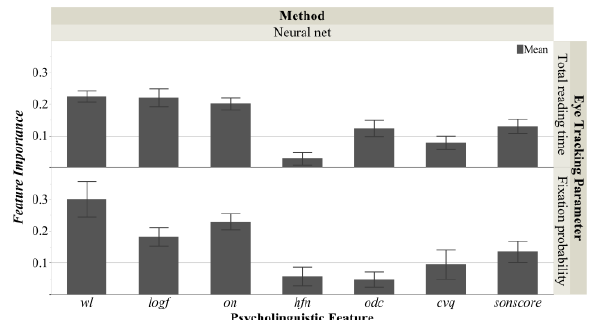
Figure 3 . Feature Importances for Total Reading Time and Fixation Probability. Figure 3 shows the feature importances ( FI s) for the neural net model. The FI s were calculated by using the dependent resampled inputs option and mean total effects of 1000 iterations. The total effect is an index quantified by sensi- tivity analysis, which reflects the relative contribution of that feature both alone and in combination with other features (for details, see Saltelli, 2002). All seven psycholinguistic features were computed for all unique words (word-type, 205 words, data for words appearing several times in the texts were the same) in the three sonnets based on the Gutenberg Literary English Corpus as reference (GLEC; Jacobs, 2018a): wl was the number of letters per word; logf was log transformed word, on was the number of words of the same length as the target differ- ing by one letter, hfn was the number of orthographic neighbors with higher word frequency than the target word; odc was the target word’s mean Levenshtein distance from all other words in the corpus; cvq was the quotient of consonant and vowels in one word; sonscore was a simplified index based on the sonori- ty hierarchy of English phonemes which yields 10 ranks (Clem- ents, 1990; Jacobs & Kinder, 2018). Each error bar is